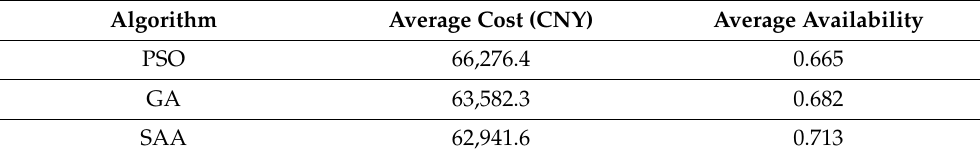
Figure 8. Optimal value of each algorithm run. ( a ) Changes in availability, ( b ) Changes in warranty cost. Table 3. The results and operation time of each algorithm.